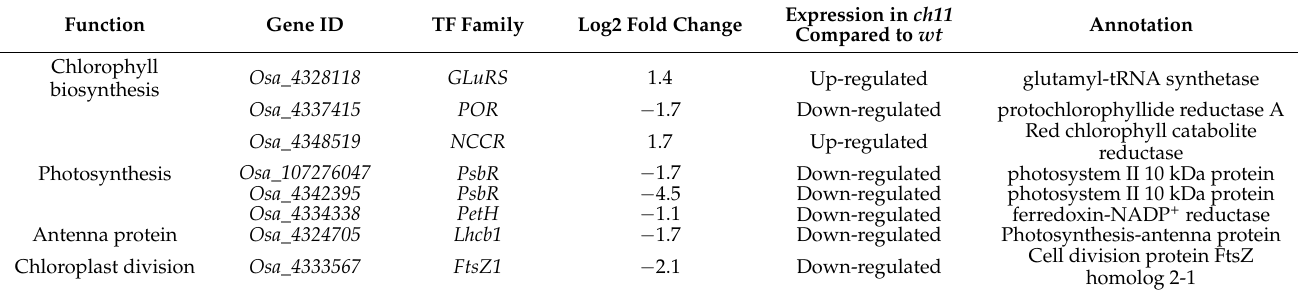
Table 1. Distribution of unigenes amongst KEGG pathways containing differentially expressed genes.